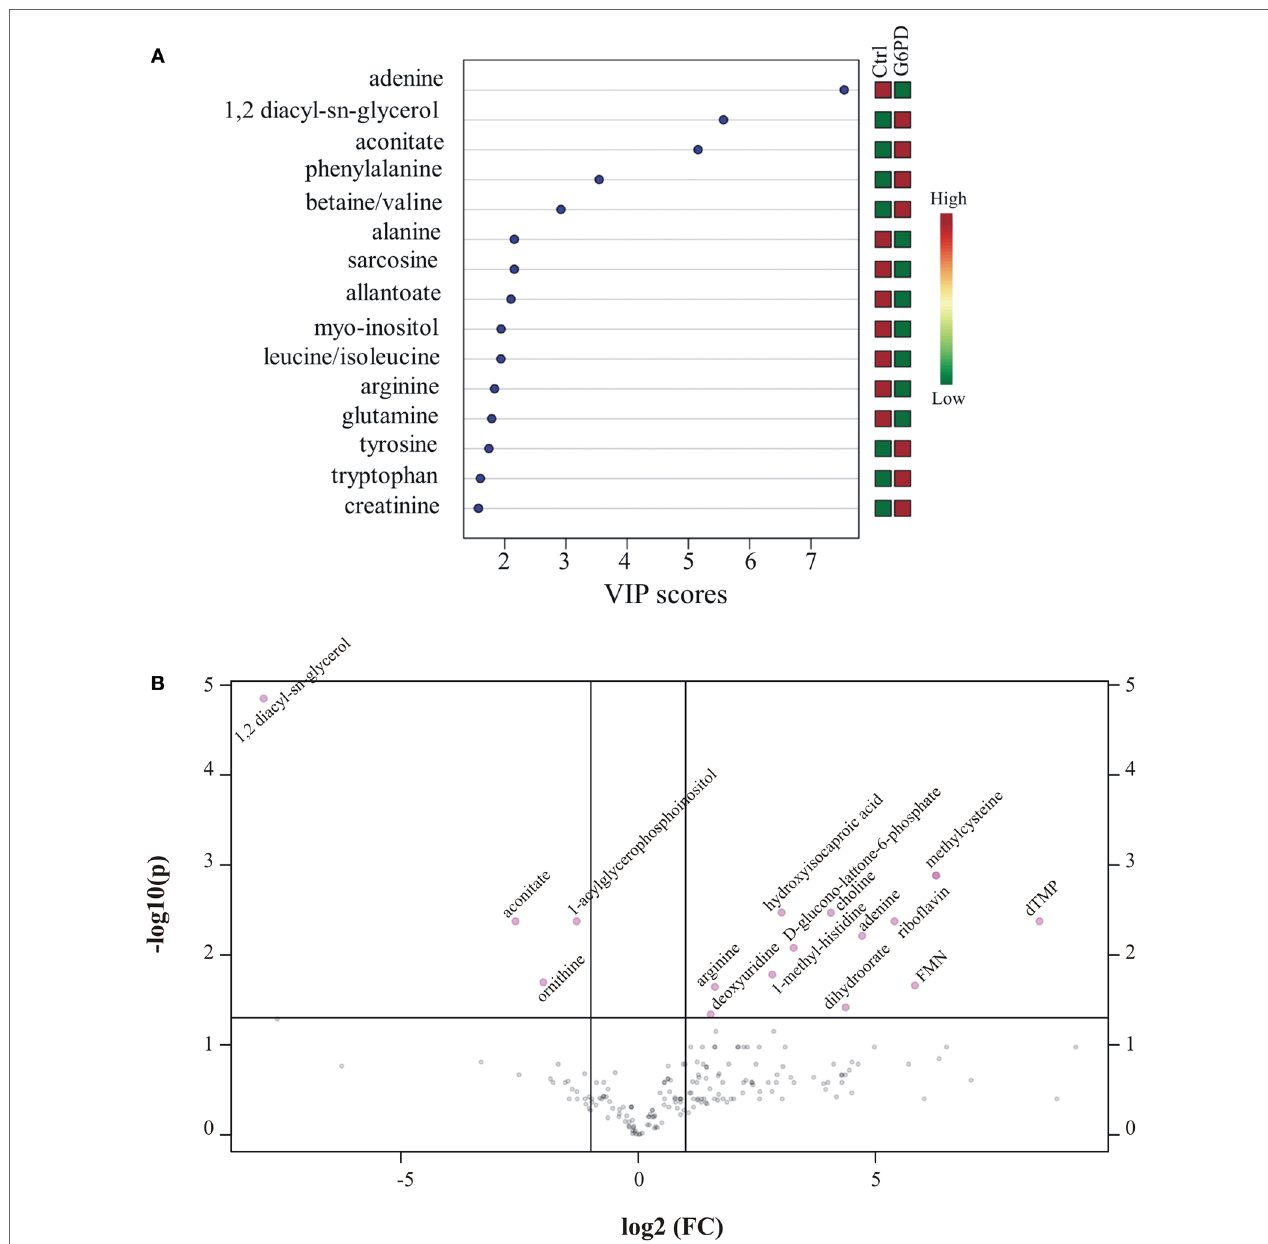
FigUre 4 | Important features identified by uni- and multivariate analyses. (a) G6PD − vs. control variable importance in projection (VIP) plot; colored boxes on the right indicate the relative concentrations of the corresponding metabolite in each group under current study. (B) Volcano plot showing the distribution of the fold changes in metabolite concentrations. Metabolites with absolute fold change > 2 and adjusted p -value (FDR < 0.05) are indicated in pink. Comparisons were analyzed using Student’s t